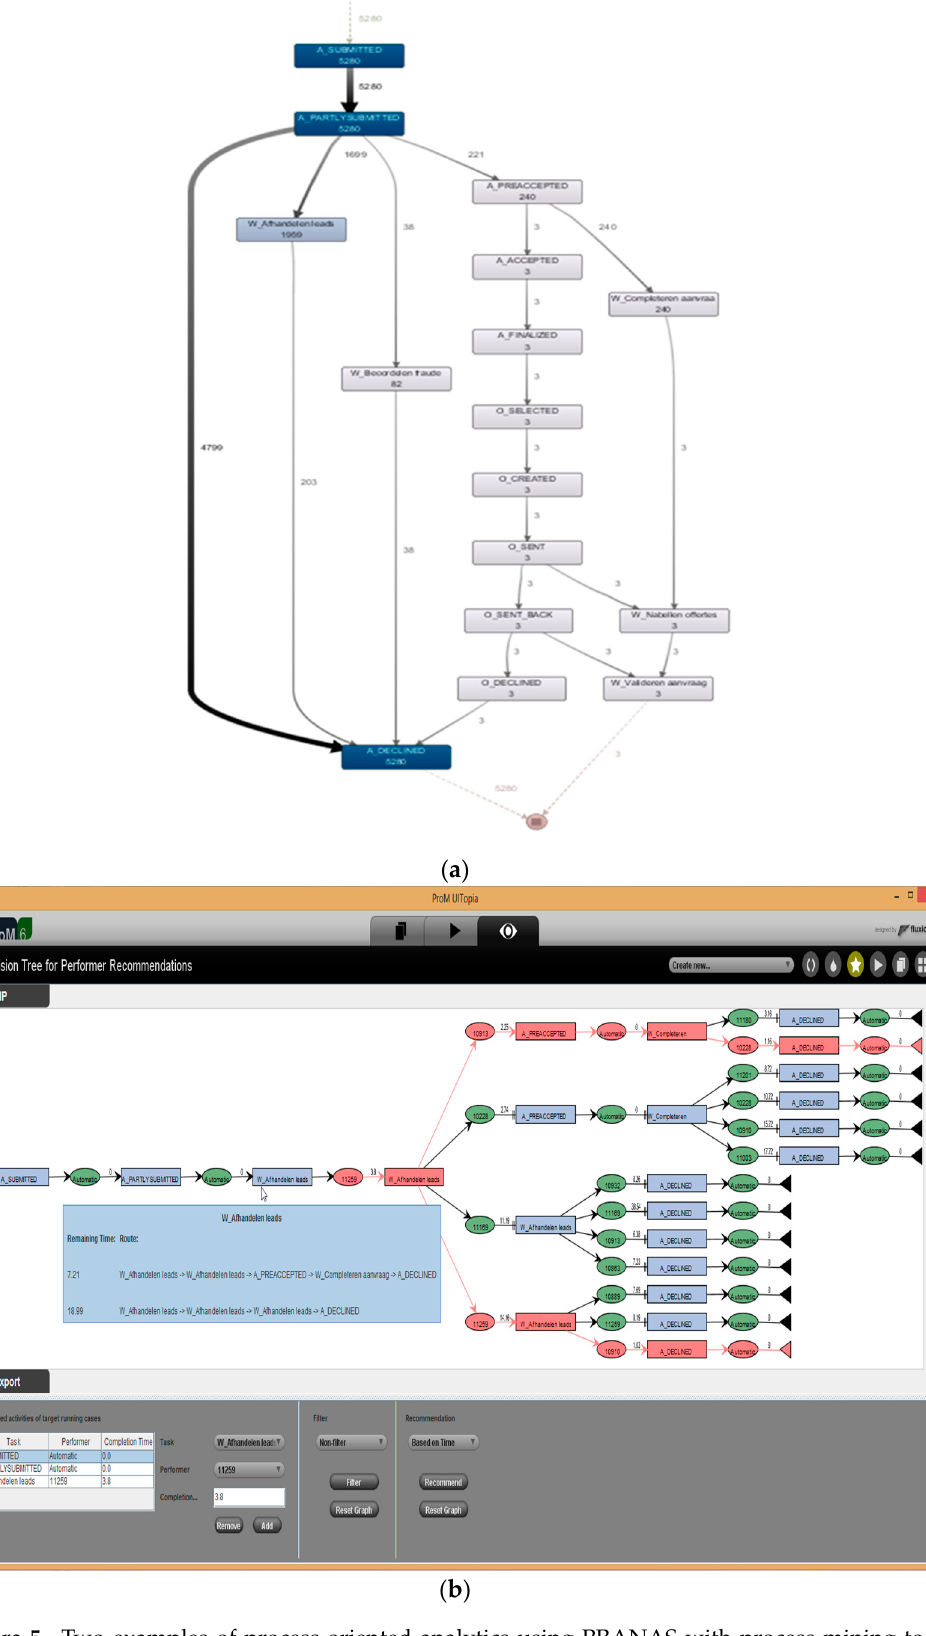
Figure 5. Two examples of process-oriented analytics using PRANAS with process mining tools. ( a ) Discovered subprocess model; ( b ) Decision tree for performer recommendation using DTMiner.